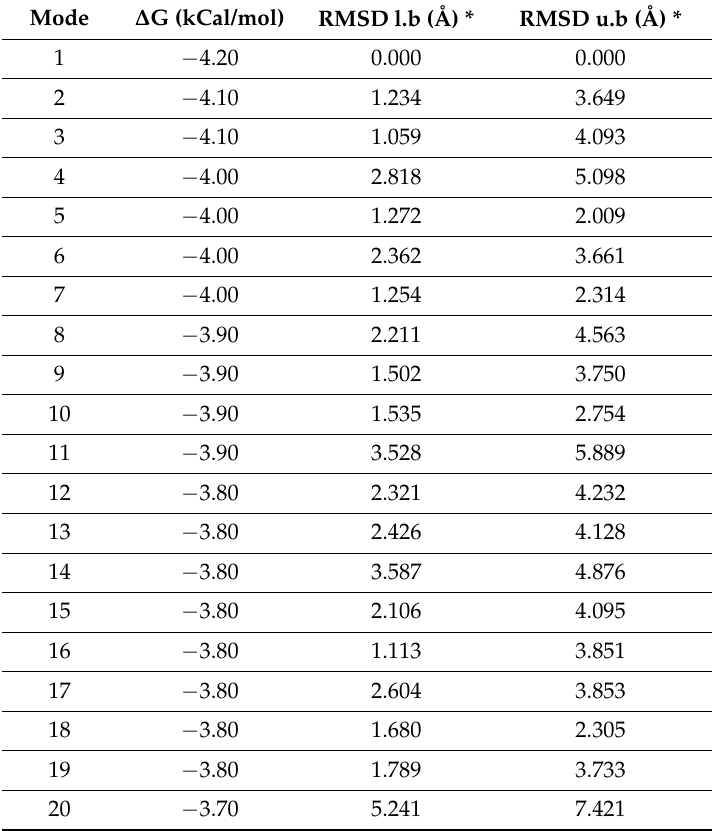
Table 2. Docking results of graphene oxide and β - D -glucose in a direct sensing model.